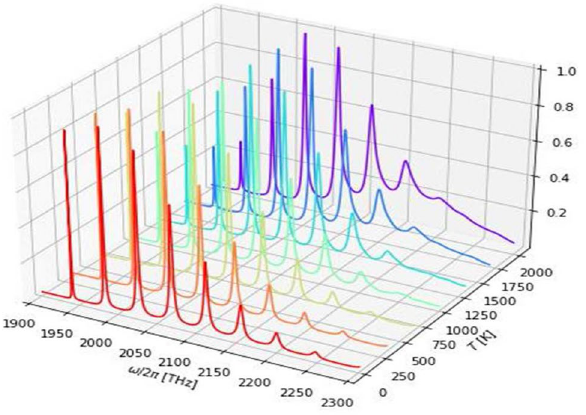
Figure 3. Absorption lineshape of carbon monoxide with varying temperature (y-axis) in the case when M eg and M ge are expanded fully. The same parameters as in Fig. 2 were used.